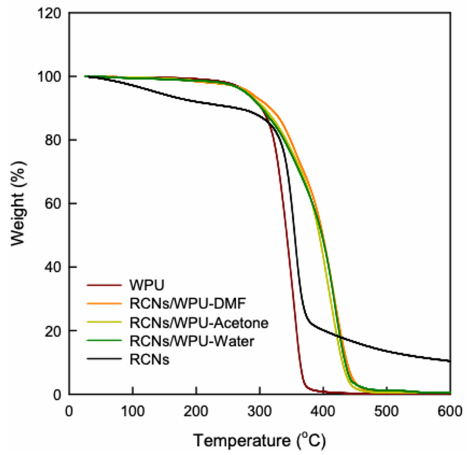
Figure 7. TGA properties curves of RCNs, WPU, RCNs/WPU nanocomposites